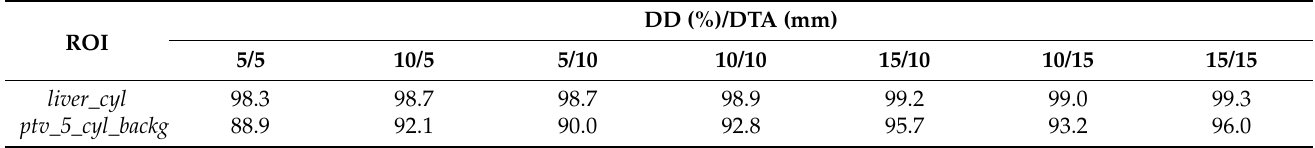
Table 3. γ -index PR (%) in phantom ROI considering seven DD (%)/DTA (mm) test